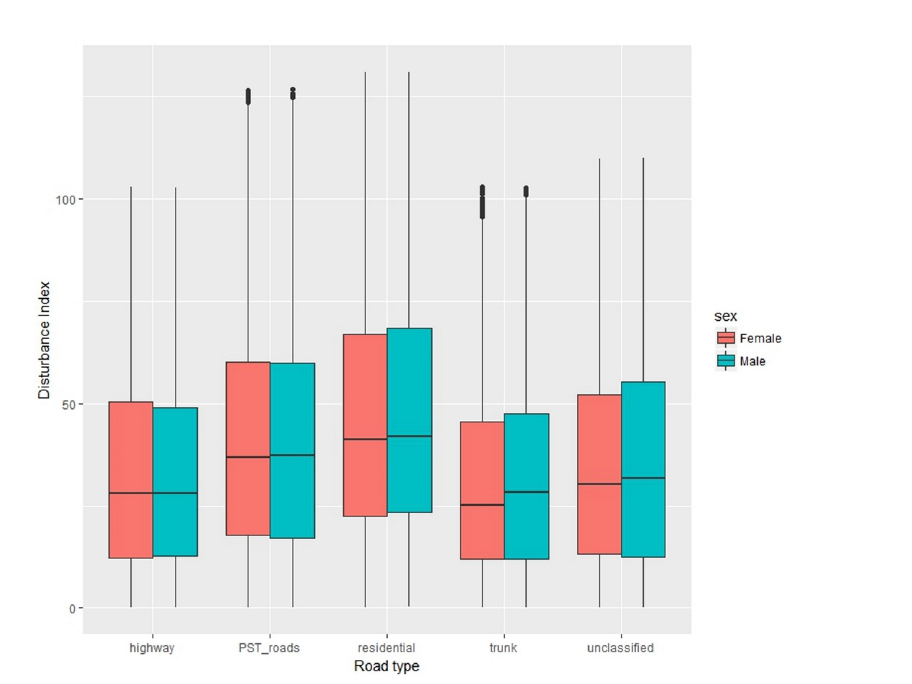
Fig 11. Individual disturbance for men and women on different